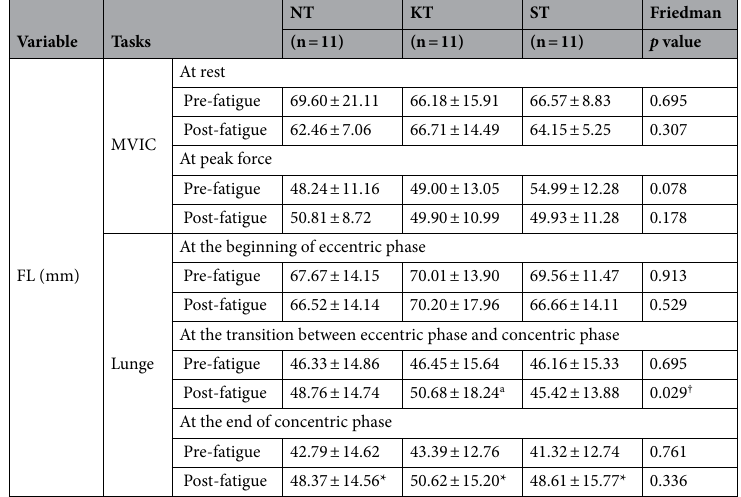
Table 4. Fascicle length of medial gastrocnemius muscle. Data are presented as means + SD. NT No taping; KT Kinesio taping; ST Sham taping; SD Standard deviation; MVIC Maximum voluntary isometric contraction. *Statistically significant difference pre- and post-fatigue (Wilcoxon signed-rank test, p < 0.05). † Statistically significant difference between NT, KT and ST groups (Friedman test, p < 0.05). a Statistically significant difference to the ST group (Wilcoxon signed-rank test, p <